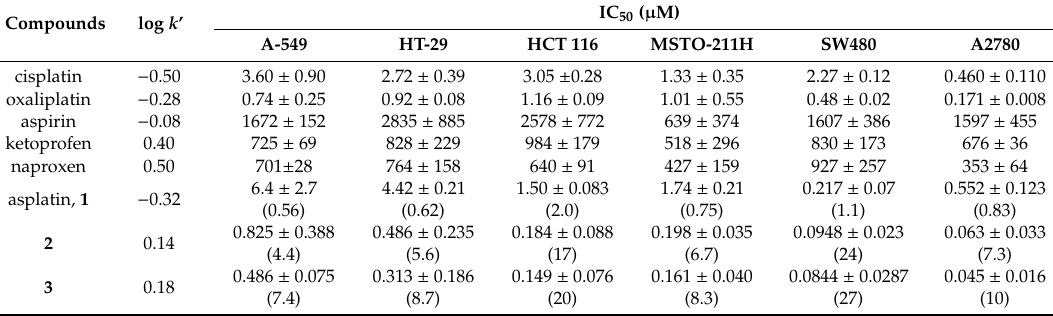
Figure 4. Cyclooxygenase (COX)-2 cDNA level of expression ( ∆ Cq) in A-549, HT-29, HCT 116, MSTO-211H, A2780, and SW480 cells. Data are means ± SEM (standard error of mean) of at least three independent replicates and were compared by means of a one-way ANOVA analysis of the variance-Tukey test (no indication = not significant; * p < 0.05; ** p < 0.01; *** p < 0.001 vs. SW480). Table 1. Lipophilicity (log k ’) and antiproliferative (IC 50 ) data for complexes 1 – 3 , together with cisplatin, oxaliplatin, aspirin, ketoprofen, and naproxen. IC 50 data ( µ M) were obtained after 72 h of treatment of the following cancer cell lines: Lung A-549, colon HT-29, HCT 116, SW480, ovarian A2780 cancer cell lines, and malignant pleural mesothelioma MSTO-211H. Data are means ± standard deviation (SD) of at least three independent replicates. Numbers in parenthesis are the ratios R = IC 50 (cisplatin) / IC 50 (Pt(IV) conjugate) reported with two significant